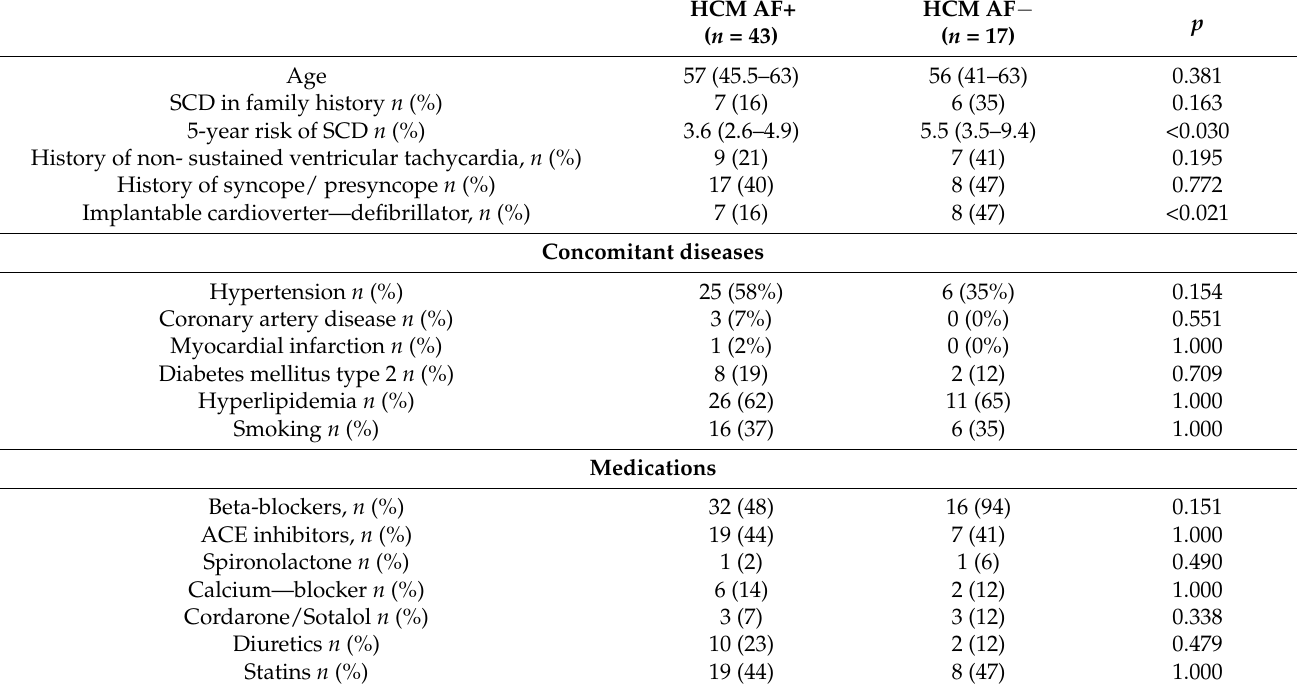
Table 1. Clinical characteristics of HCM AF+ and AF −